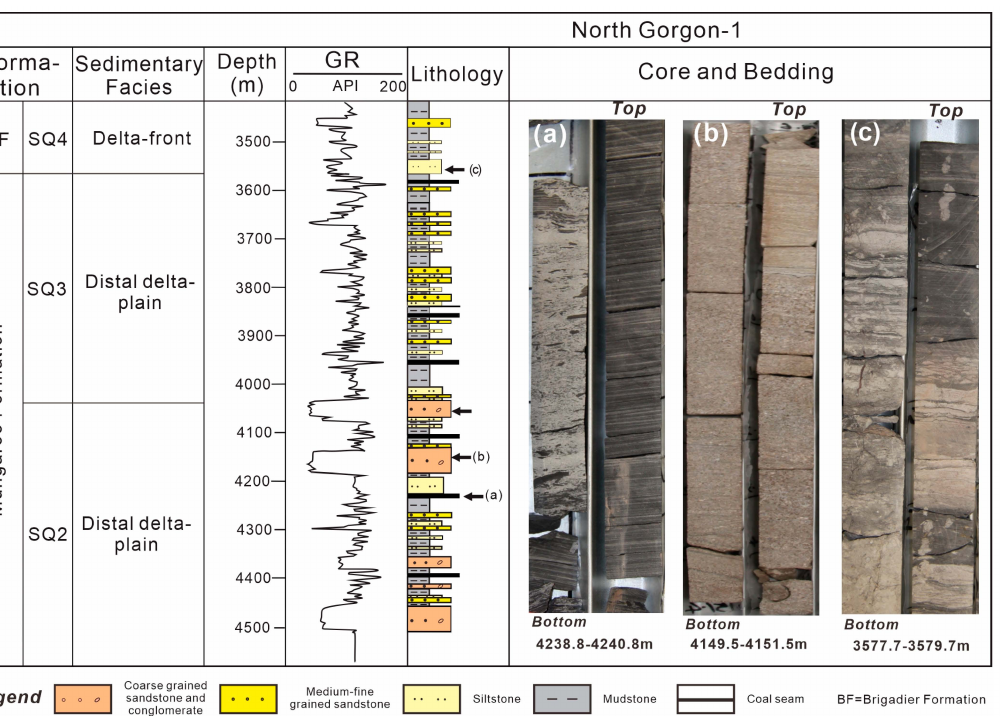
Figure 4. The gamma ray (GR) wireline log, lithologies and vertical evolution, delta–marine sedi- mentary facies, and the related cores and crossbedding sedimentary structures from North Gorgon-1. The depositional strata are related to the Mungaroo and Brigadier Formation (BF) from SQ2 to SQ4. The drilled cores’ photos indicate the depositional features of the ( a ) coal seam and carbonaceous mudstone, ( b ) coarse grained sandstone and conglomerate of the distributary channel sandstone, and ( c ) interbedding of the distributary channel sandstone and mudstone of the interdistributary channel bay.